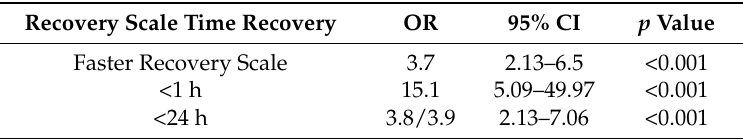
Table 2. Odds ratio (OR) and confidence interval (CI) for recovery outcomes. Non-squeezed group versus squeezed